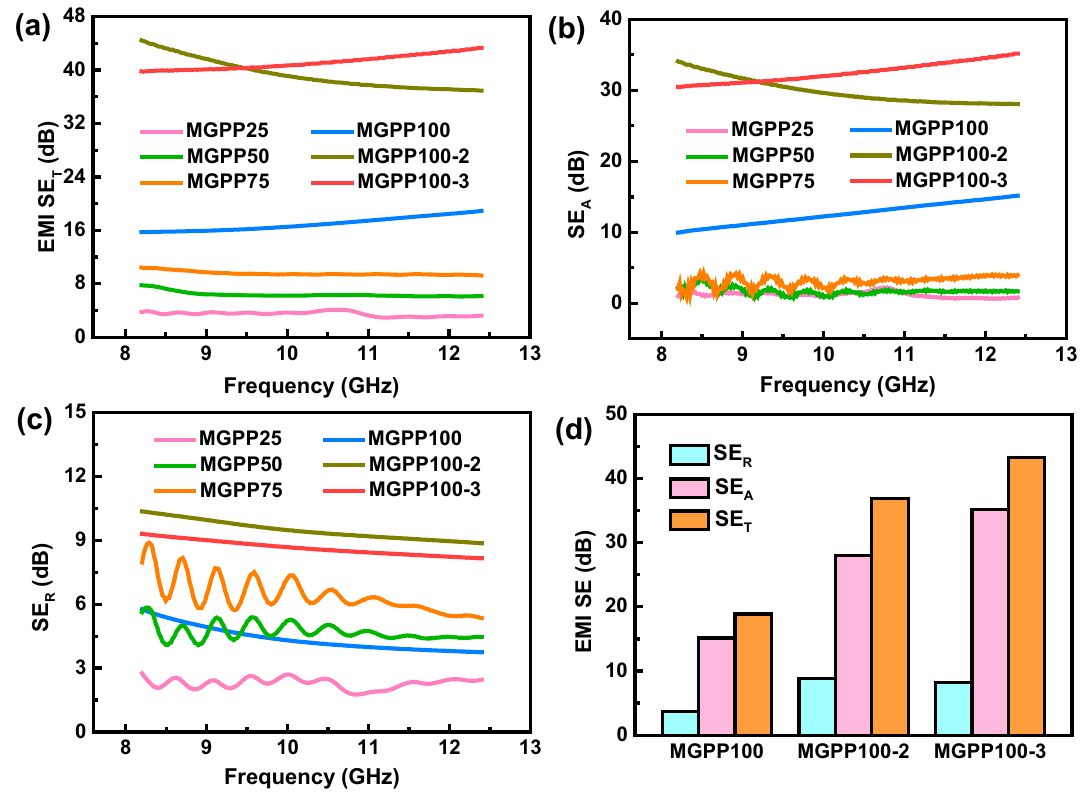
Fig. 7 a SE T , b SE A , and c SE R of MGPP composites at X bandwidth. d EMI shielding performance comparison of MGPP composites at 12.4